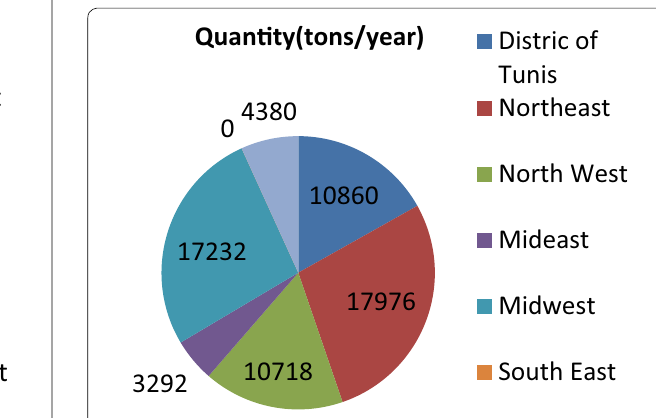
Fig. 14 Waste from the timber